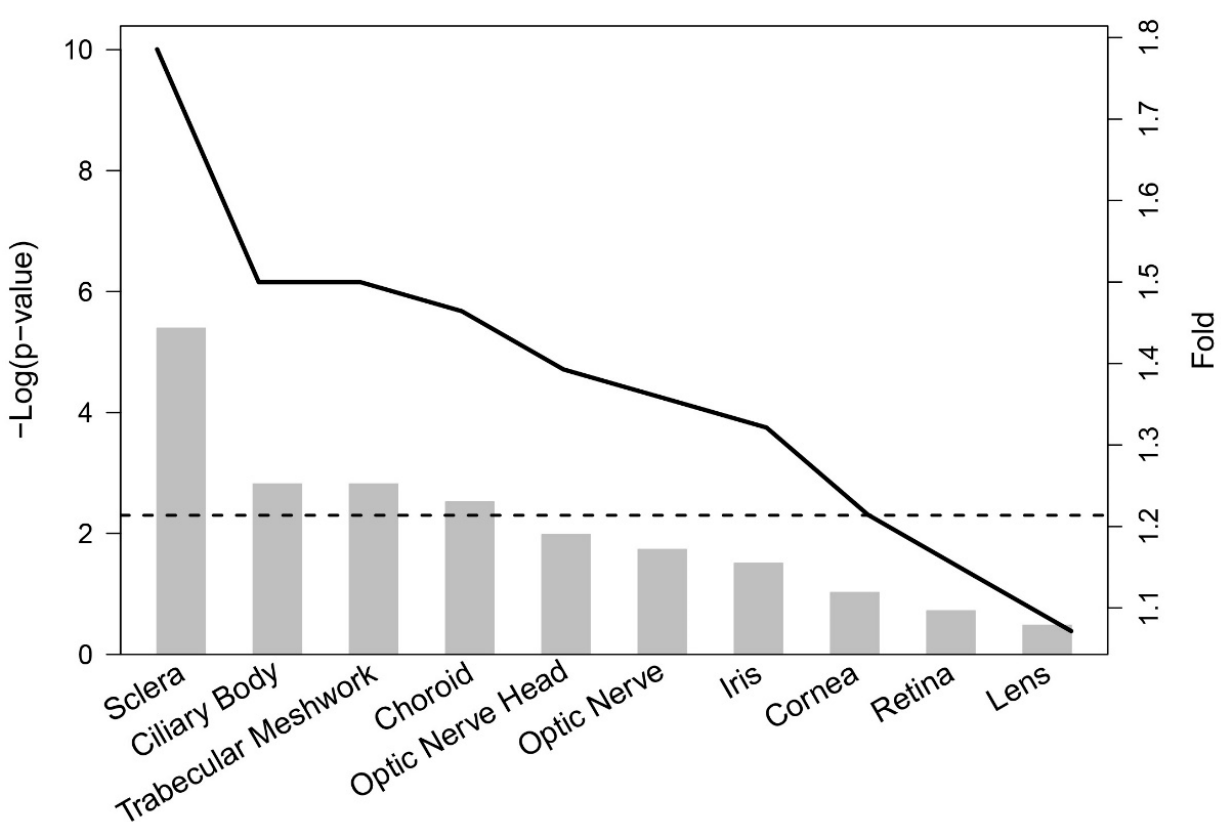
Figure 5. Bar graph showing enrichment in ten ocular tissues of 112 available prioritized genes (out of the total of 142) amongst the genes in the ocular tissue database with gene expression values in the top 25%. Bars show the significance of overrepresentation (y-axis left), dashed horizontal line running through the bars is the threshold for p -value < 0.005 (adjusted for multiple testing), and the solid black line shows the fold of overrepresentation (y-axis right).